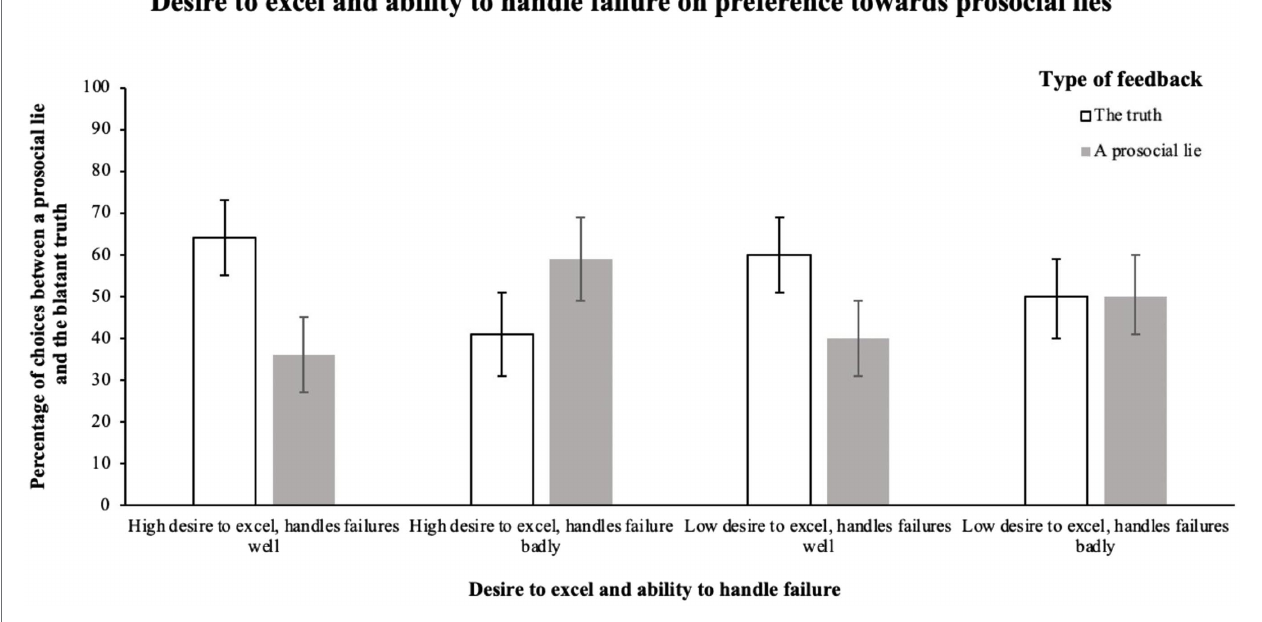
FIGURE 1 | The effect of the desire to excel in a task and ability to handle failure on preference toward overly positive feedback. Figure shows percentage of the preference toward prosocial lies within each condition. Error bars represent 95% confidence